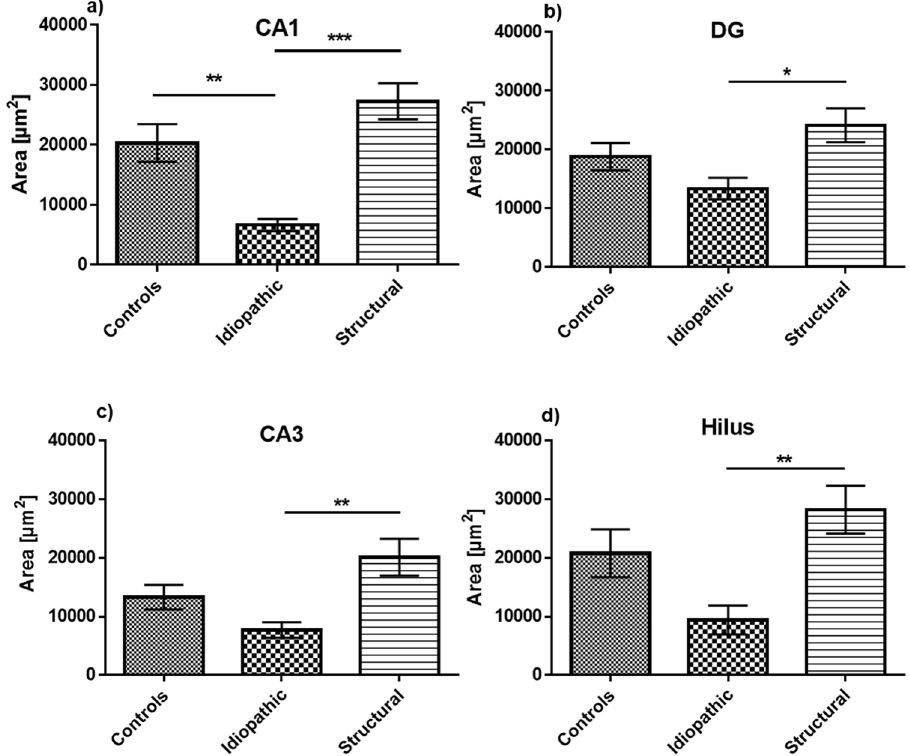
Figure 2. Analysis of the hippocampal CB1R-immunopositive area. In the CA1 region ( a ) the CB1R- immunopositive area was decreased in idiopathic epilepsy in comparison to structural epilepsy and controls. In DG ( b ), CA3 ( c ) and hilus ( d ) the area expressing CB1R in idiopathic epilepsy was significantly smaller in comparison to structural epilepsy, but did not differ significantly to controls; error bars indicate SEM and asterisks in the figures indicate significant differences, * p < 0.05, ** p < 0.01, *** p < 0.001; CA: Cornu Ammonis; DG: dentate